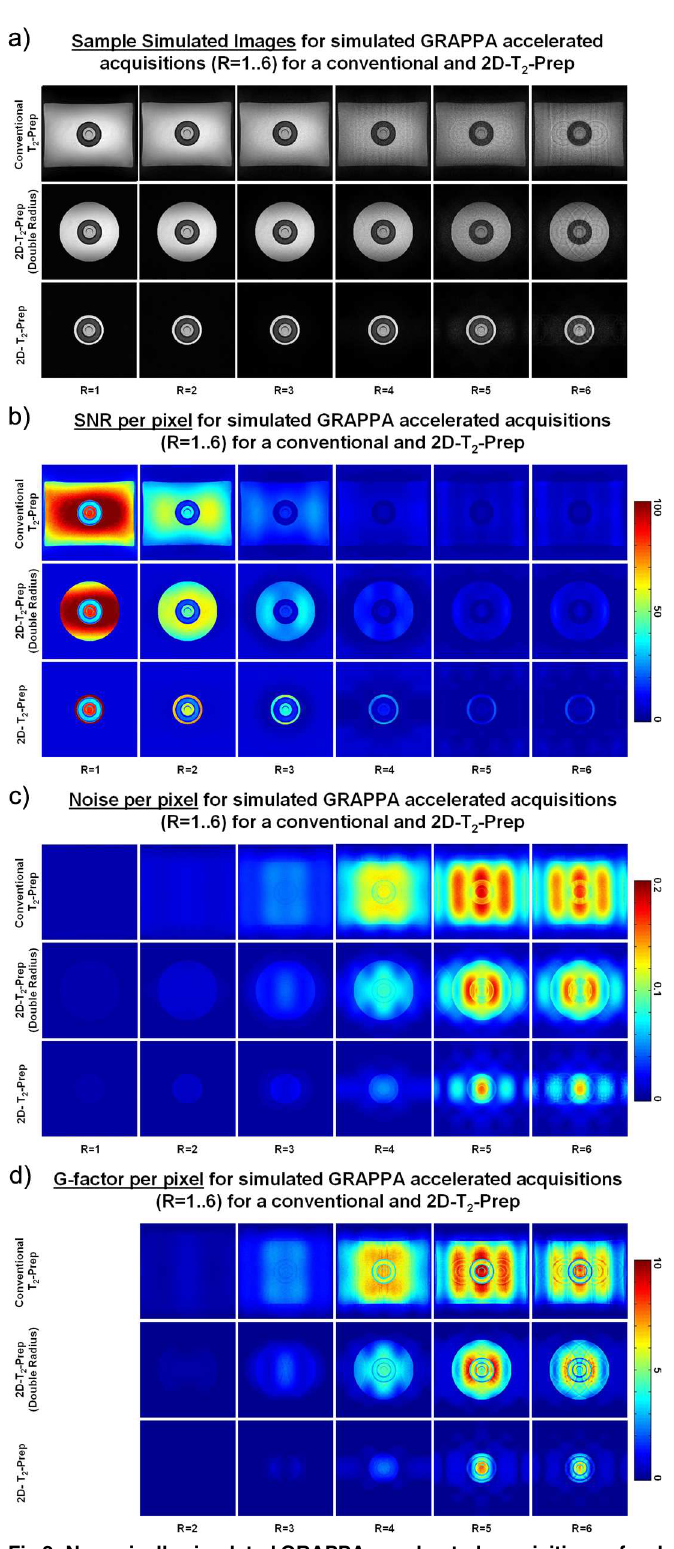
Fig 2. Numerically simulated GRAPPA-accelerated acquisitions of a phantom. Random coil noise was added to the 50 scan averagedescribedin Fig 1C) for the conventional T 2 -Prep as well as for 2D-T 2